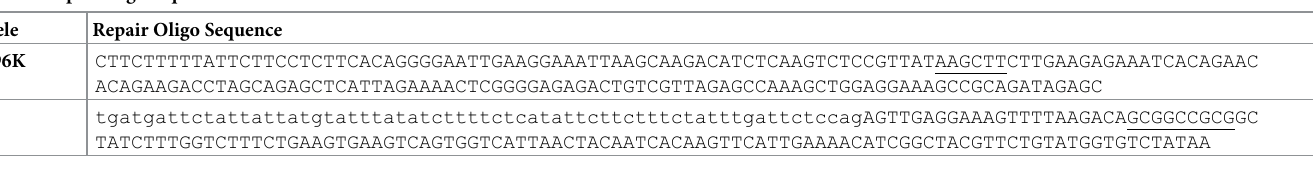
Table 1. Repair oligo sequences.